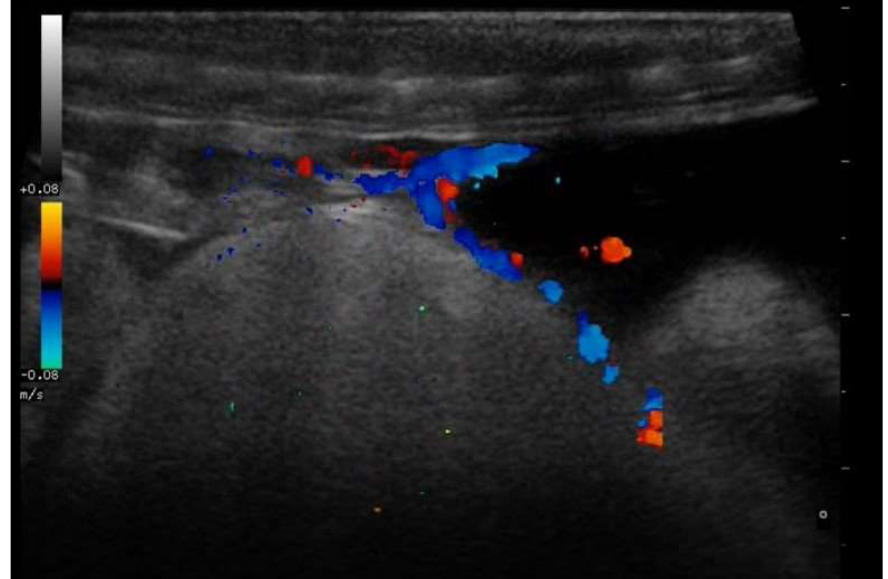
Figure 13. Vascular connections in a gravid female boa 38 days after ovulation—flow towards the transducer is depicted in red, while flow away from the transducer is shown in blue. Through Doppler, it was possible to highlight vascular connections between the mother and the egg membrane in all pregnant females.